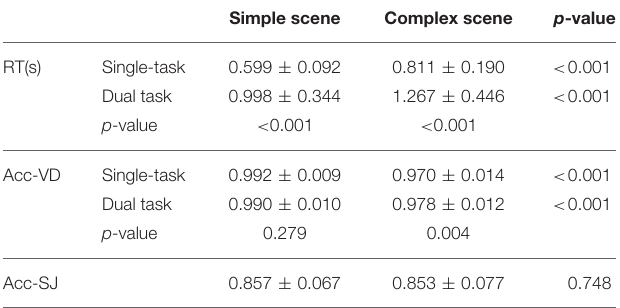
TABLE 2 | Results of behavioral